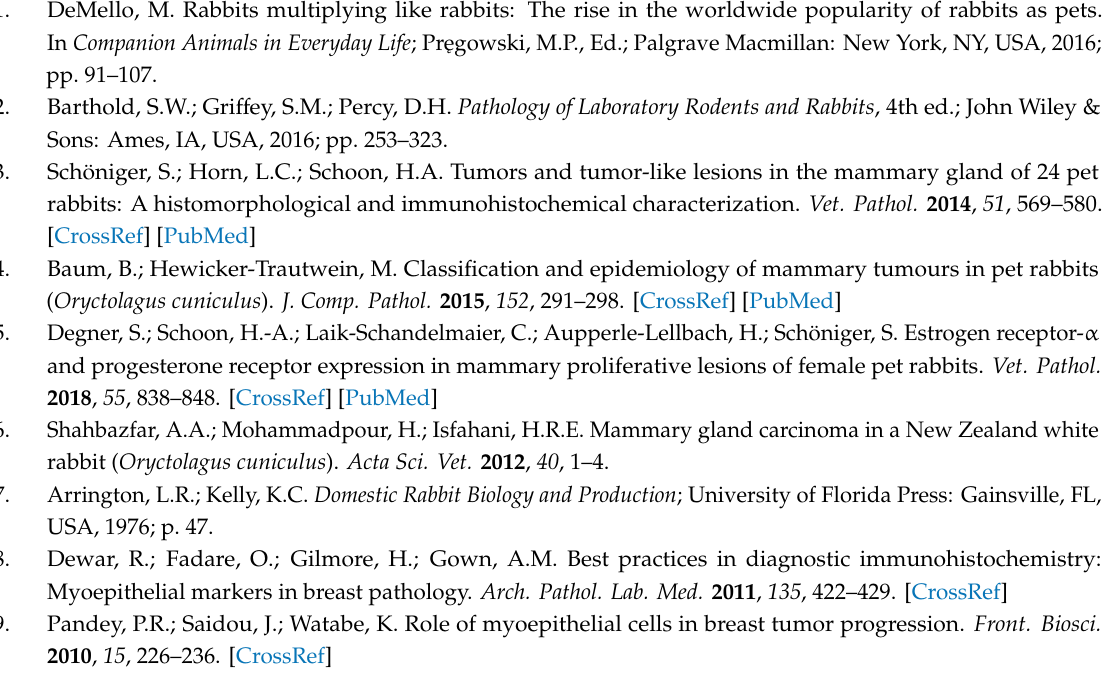
Figure S1: Negative and positive controls for the immunostaining of rabbit mammary carcinomas for cytokeratin AE1 / AE3, smooth muscle actin, vimentin and calponin, Figure S2: Image analysis to determine immunopositive areas for smooth muscle actin, vimentin, calponin and cytokeratin AE1 / AE3, Figure S3: Median values for smooth-muscle actin-, vimentin- and calponin-immunostaining of spindle-shaped and hyperplastic non-neoplastic myoepithelial cells, Figure S4: Association between percentages of spindle-shaped and hypertrophic myoepithelial cells and the age of the rabbits, Figure S5: Scatter plots to depict the relationship between calponin-positive tumor cells and the size of the tumor area with a tubular growth or the mitotic count,